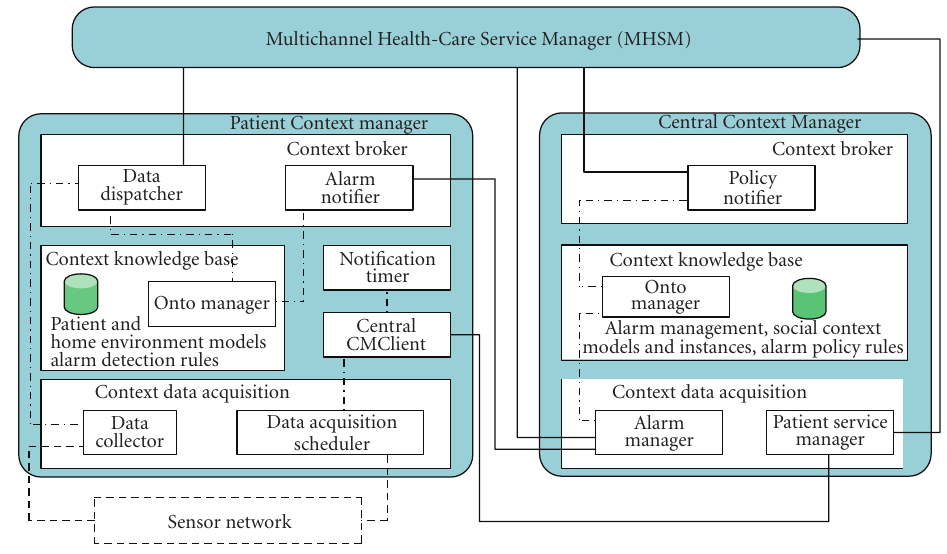
Figure 3: ERMHAN Context Management system.